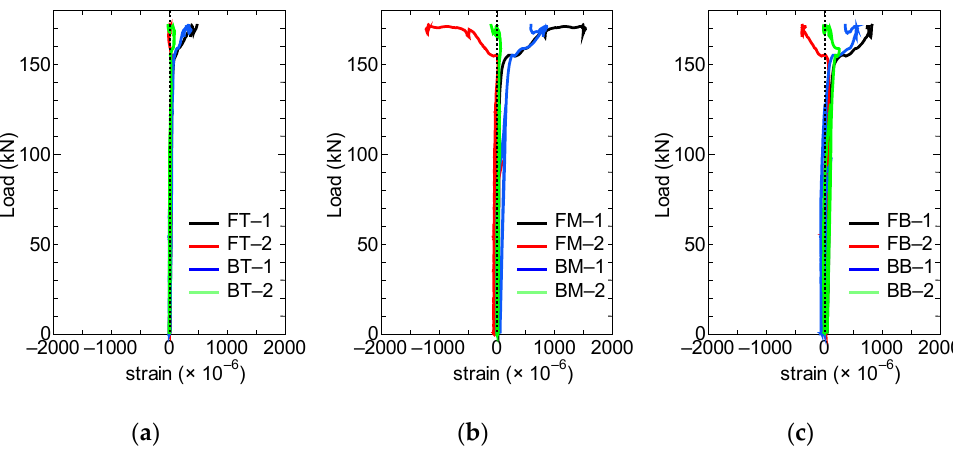
Figure 12. Relationship between applied load and strain of transverse reinforcements of Type-A: ( a ) Top series; ( b ) Middle series; ( c ) Bottom series (locations of measured strains in Figure 5e1,e2).